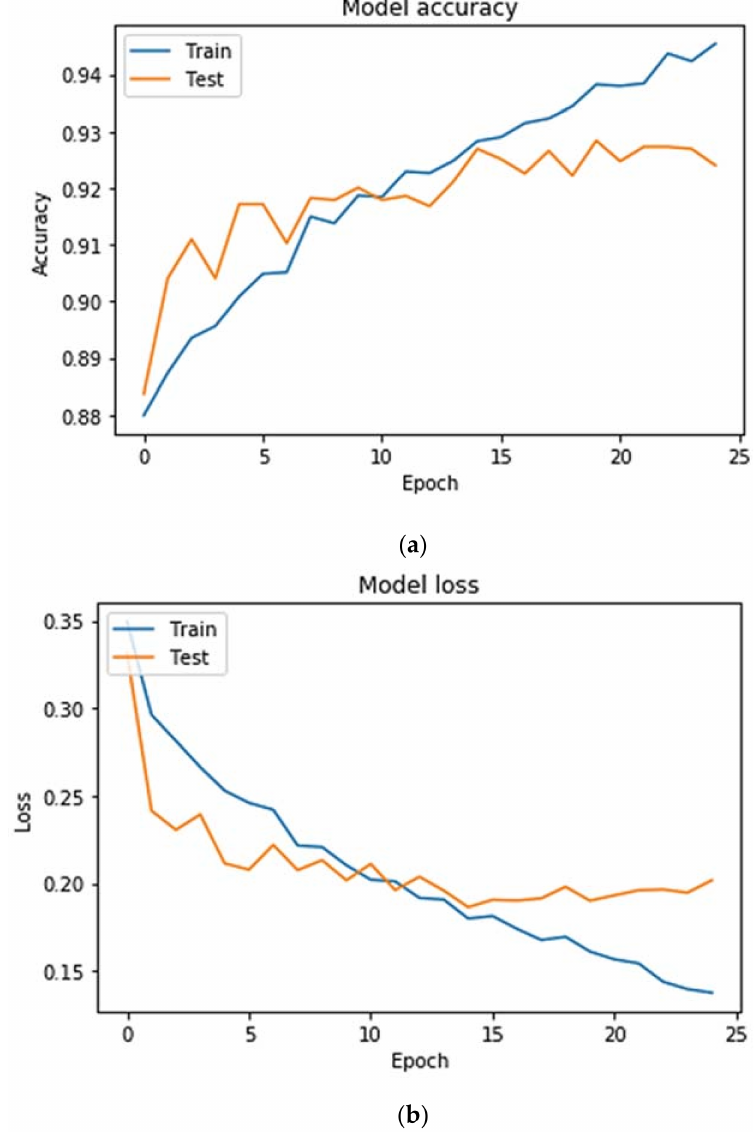
Figure 3. ( a ) LSTM training accuracy graph and ( b ) LSTM model loss graph. In Figures 4b and 5b, confusion matrix graphs are plotted for both configurations and each column represents the predicted class instances. The confusion matrix is shaded